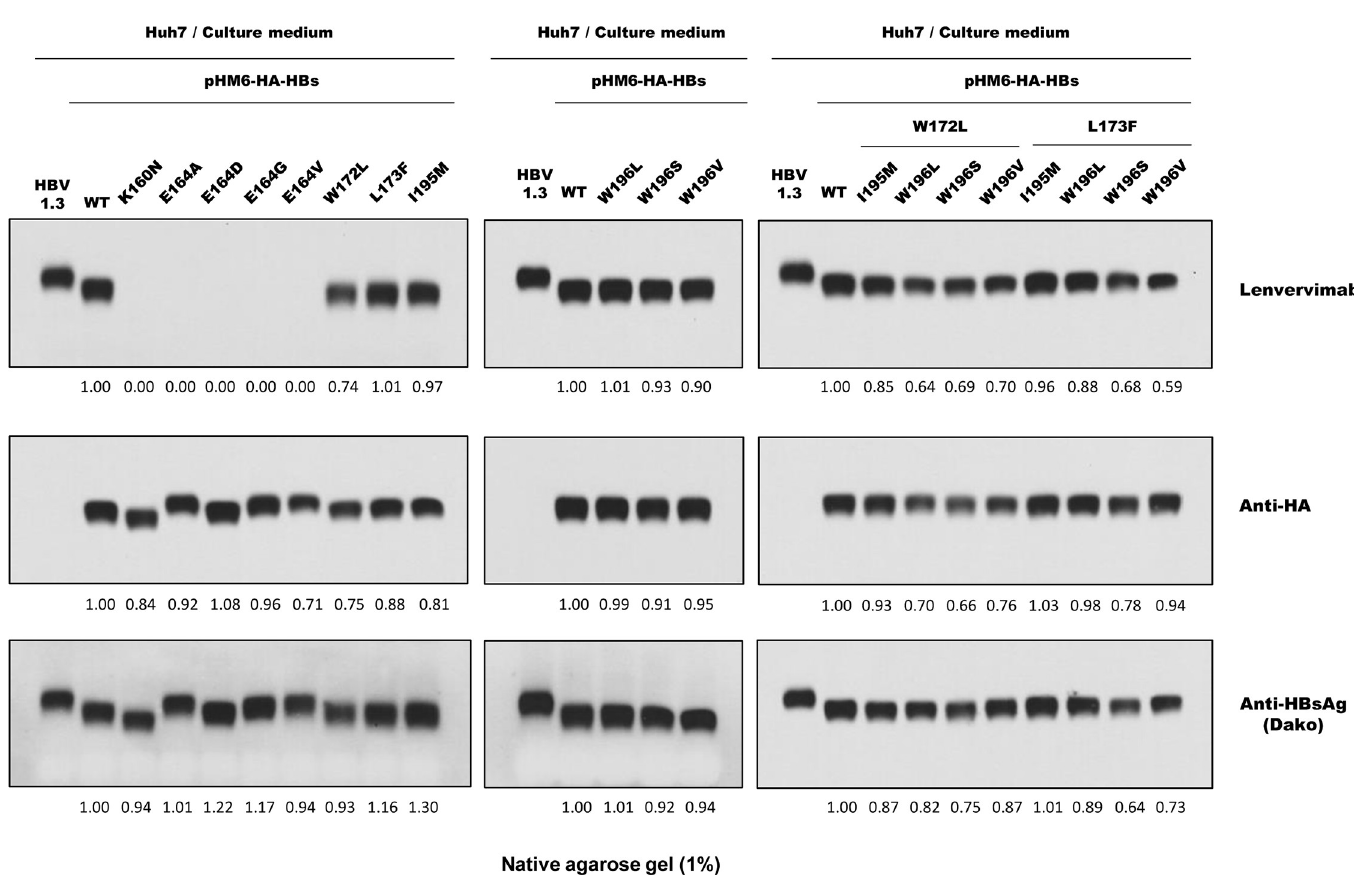
Fig 6. Lenvervimab binds S antigens of drug-resistant variants. (A) S antigen variations associated with drug-resistant viral polymerase mutations were separated by native agarose gel and immunoblotted with Lenvervimab (upper), anti-HA (middle) or polyclonal anti-HBsAg (lower) antibodies. Lenvervimab binds S antigens of most drug-resistant mutants except for those with mutations at residue E164. Lenvervimab binding was also impaired by mutation at residue K160, which is unrelated to drug resistance but is considered to be an antigenic element.